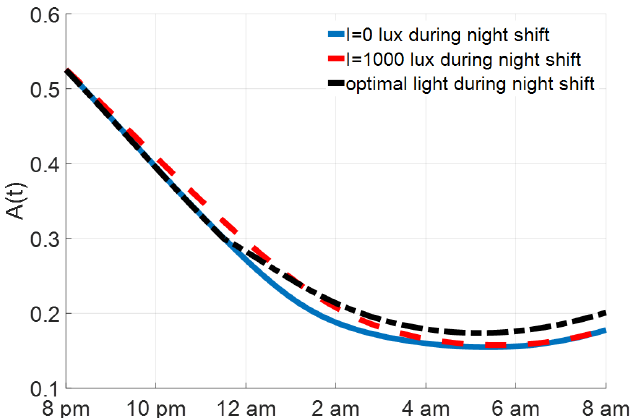
Figure 7. The alertness level of the night-shift workers with goggles (blue solid line), the bright light of 1000 lux (red dashed line), and optimal light I ∗ ( t ) (black dashed line, solved by the algorithms in Section 3) from 8 pm to 8 am. The cumulative alertness (and the average subjective alertness in VAS) of these three cases are 3.02 (44.53 mm), 3.15 (45.27 mm), and 3.19 (45.47 mm),